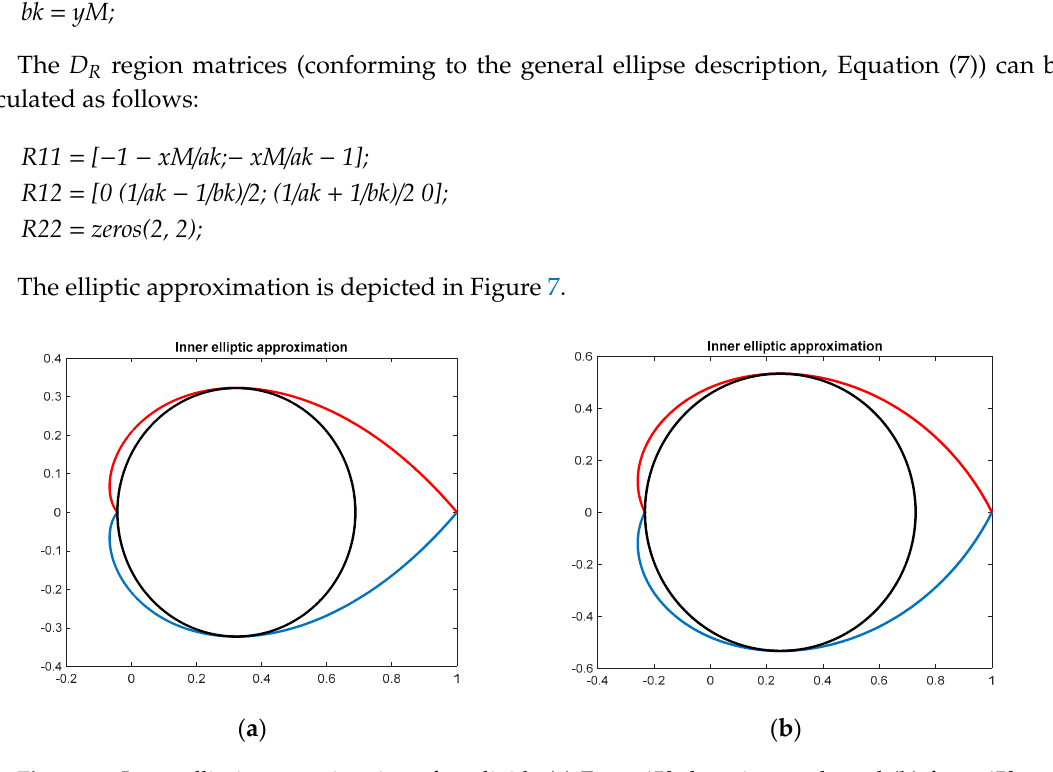
damping angle. Figure 6. Inner circle approximation of cardioid: ( a ) For a 45° damping angle and ( b ) for a 65°